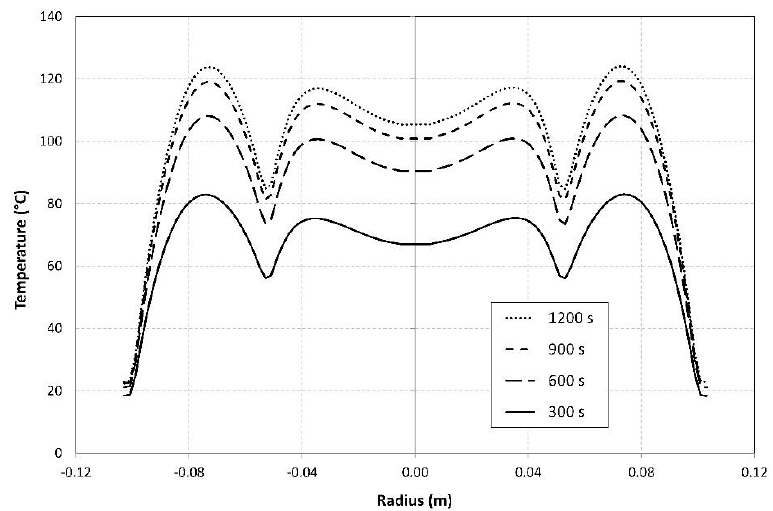
Figure 9. Changes in the temperature over time in the radial direction in Geometry